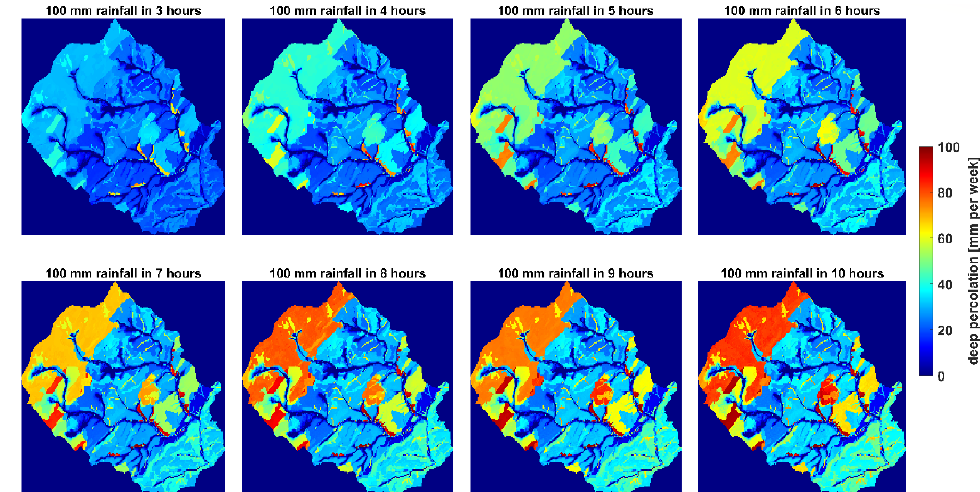
Figure 5. Variability in the spatial patterns of simulated deep percolation within the catchment under different synthetic rainfall intensities (PTF combination 5 from Table 1).